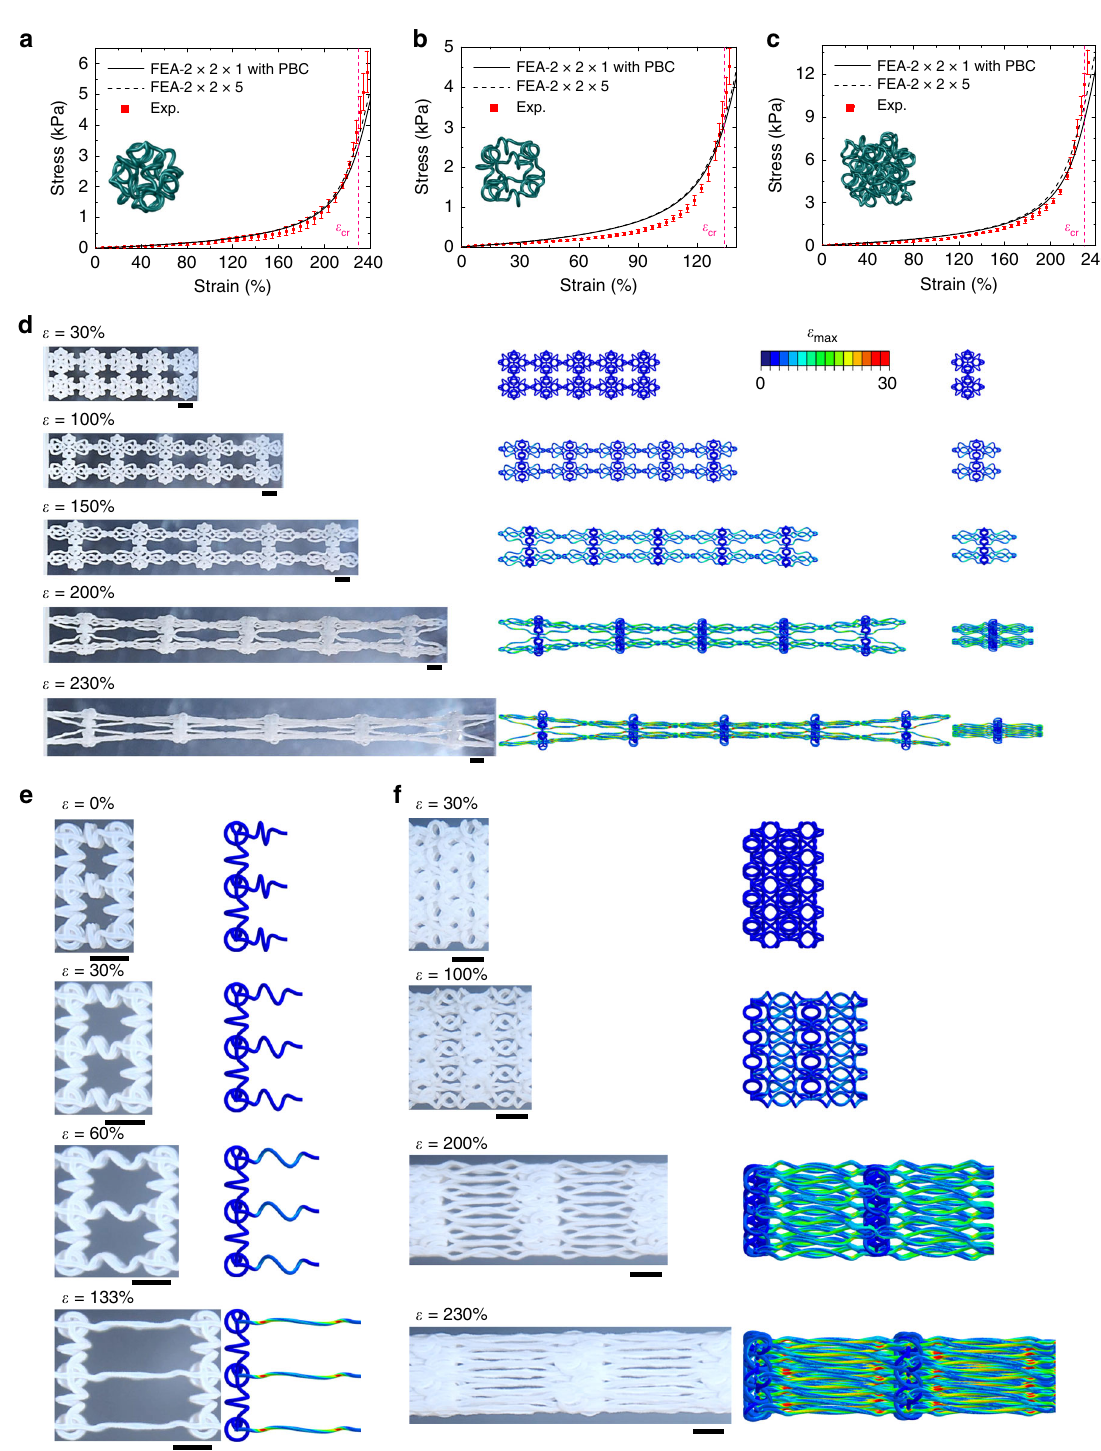
Fig. 2 Nonlinear mechanical responses and microstructure deformations. a – c Experimental and FEA results of stress – strain curves of three soft 3D network materials with the same helical microstructures and different lattice topologies (cubic, octahedral, and octet). The experimental results based on samples with 2 × 2 × 5 unit cells are denoted by red rots, and the FEA results based on unit segments with 2 × 2 × 1 unit cells, and periodic boundary conditions are denoted by black solid lines. For the octahedral lattice, the FEA results of the entire sample with 2 × 2 × 5 unit cells are included for comparison, as denoted by the black dashed line. d Optical images (left) of a soft octahedral network structure under different levels of stretching, and the corresponding FEA results (middle and right) based on the entire sample and the unit segment (2 × 2 × 1 unit cells) with periodic boundary conditions. e Experimental and FEA images of the middle segment in a soft cubic network structure under different levels of stretching. f Similar results for a soft octet network structure. All error bars in this fi gure and the followings are standard deviations. Scale bars, 5 mm in d – f